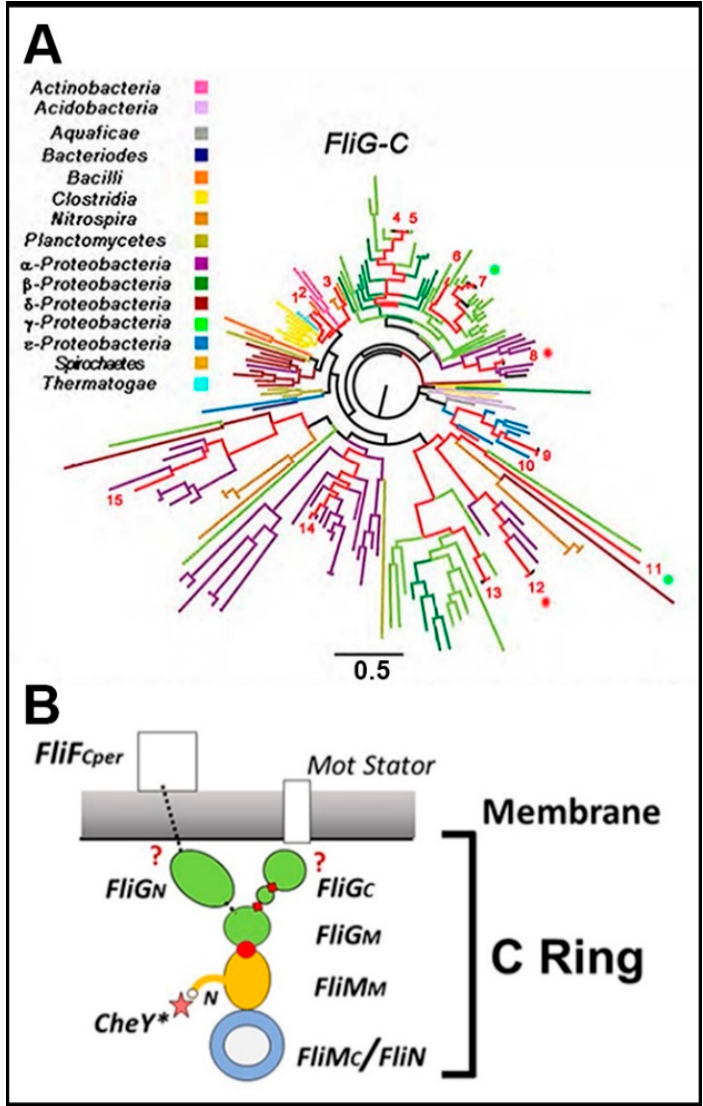
Figure 8. ( A ) The phylogenetic tree of the FliG C motor domain. 160 seed sequences (multiple sequences from 23 species). Species (red lines), with well-studied flagellar biochemistry, physiology or structure (1 = Thermatoga maritima , 2 = Bacillus subtilis , 3 = Borrelia burgdorferi , 4 = Escherichia coli, 5 = Salmonella enterica, 6 = Vibrio cholerae , 7 = Vibrio alginolyticus1 , 8 = Rhodobacter sphaeroides1 , 9 = Helicobacter pylori , 10 = Aquifex aeolicus , 11 = Vibrio alginolyticus2 , 12 = Rhodobacter sphaeroides2 , 13 = Vibrio parahaemolyticus , 14 = Caulobacter crescentus , 15 = Rhizobium meliloti ). Asterisks ( R. sphaeroides (red), V. alginolyticus (green)) mark duplicates. (from ([110])). ( B ) The signal pathways in the BFM switch for the response to chemotactic stimuli, motor torque and load. The N-terminal FliM peptide (N) anchors activated CheY (CheY*) by a flexible tether and primes it to bind additional sites on the basal C ring (FliM/FliN). The bound CheY* modulates thermal FliM N fluctuations for radial circumferential conformation spread and amplifies them via the conserved FliM M .FliG M interface (red circle), and two hinges (red diamonds) bordering FliG ARM-C to reorient the peripheral FliGc Ca1-6 sub-domain. Inter-subunit stacking between the dynamic FliG M and ARM-C modules stabilizes the FliG ring and regulates rotation reversal. The Mot stator complexes step along Ca1-6 to generate torque and influence FliG MC dynamics. The conserved co-folded FliG N /FliF C-tail domain ensures matching MS and C ring subunit stoichiometry. It is contiguous with the FliF C-terminal half (FliF Cper ) that forms a stable assembly scaffold. Co-folded domain lesions/fusions have long-range effects on C ring architecture. Thus, FliG M orchestrates bidirectional conformational coupling between FliM M and either FliG C or FliG N . The atomic details of the rotor–stator interactions or the linkage between FliG M and FliF Cper are poorly understood. The E. coli and S. enterica bacteria remain the primary source for motor rotation assays in conjunction with native and chimeric V. alginolyticus sodium motors. Structural knowledge, while anchored in these bacteria, now has important contributions from other species driven by the developments in cryo-ET and informatics. The current understanding of the flagellar motor switch is